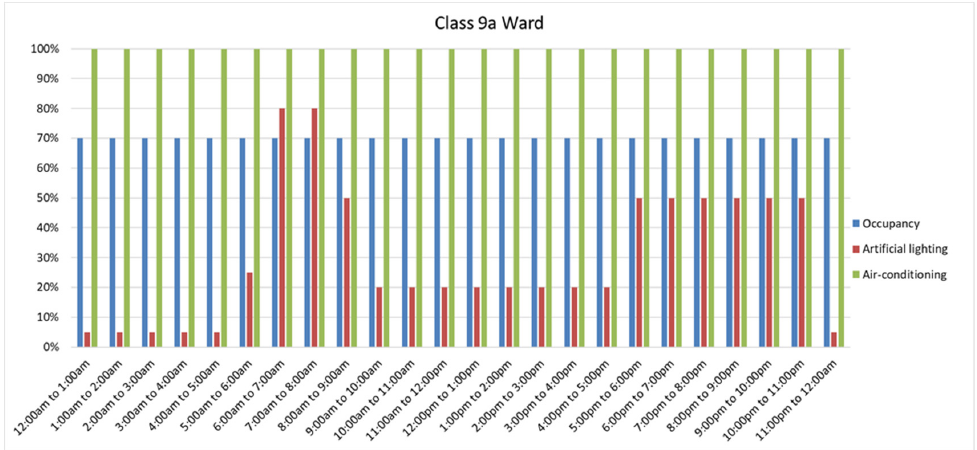
Figure 8. Operation schedules for “Class 9a Ward”.